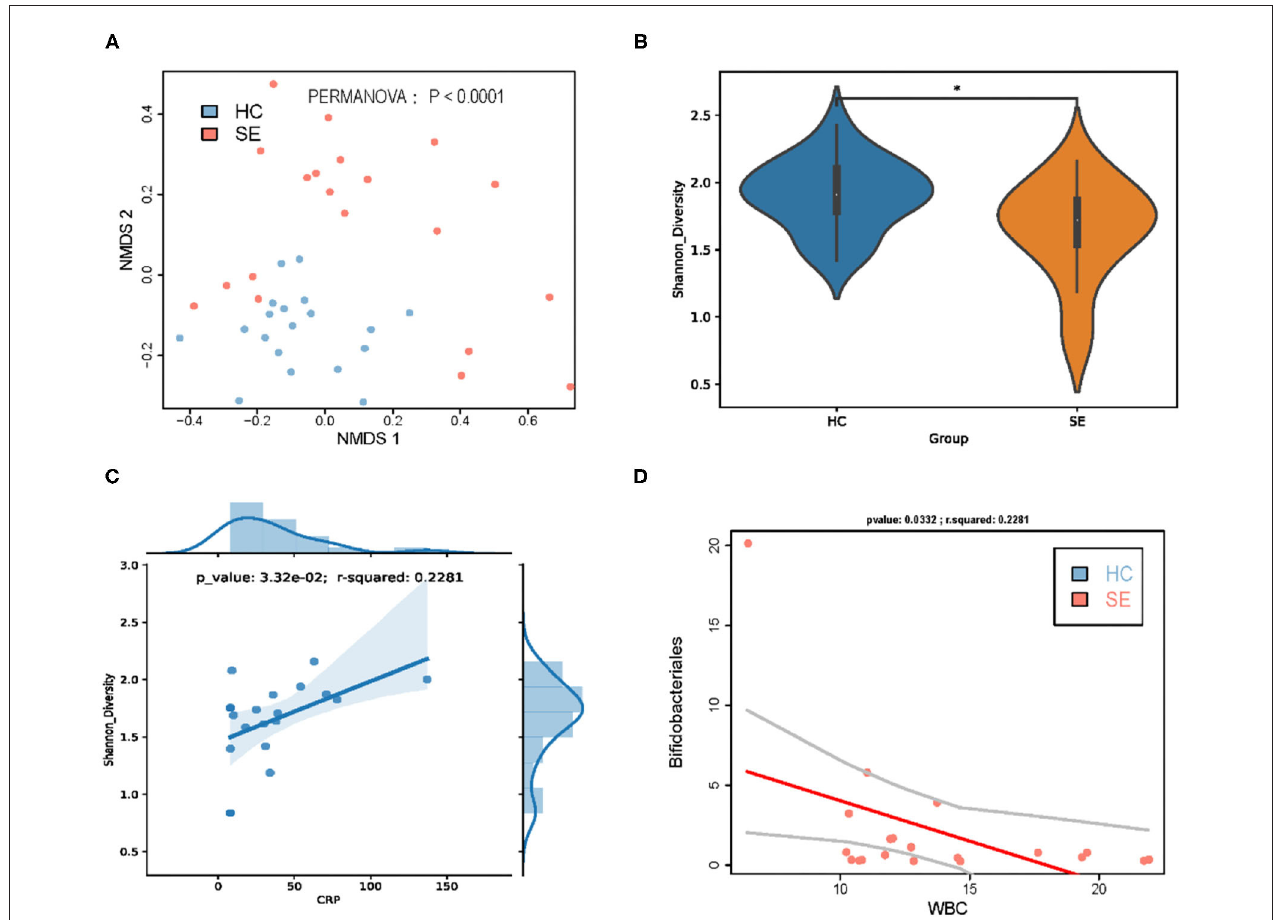
FIGURE 1 | Gut microbiota taxa distinguished sepsis patients from healthy children. (A) NMDS of taxonomic composition of gut microbiota of HC vs. SE. (B) Gut microbiota Shannon diversity of HC vs. SE. (C) In sepsis, gut microbiota Shannon diversity was positively correlated with CRP; (D) In sepsis, the gut abundance of Bifidobacteriales was negatively correlated with WBC. * p <